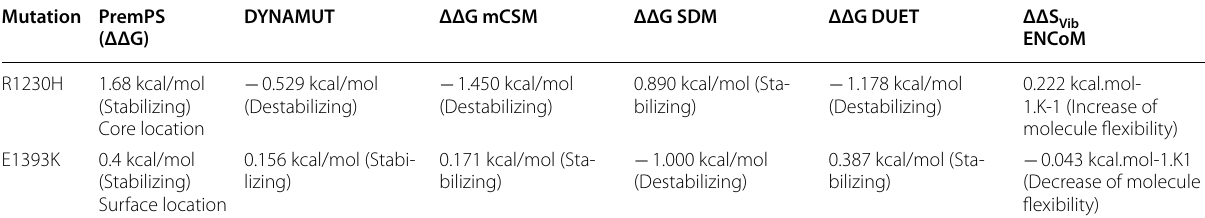
Table 10 Structure‑Based stability Predictions